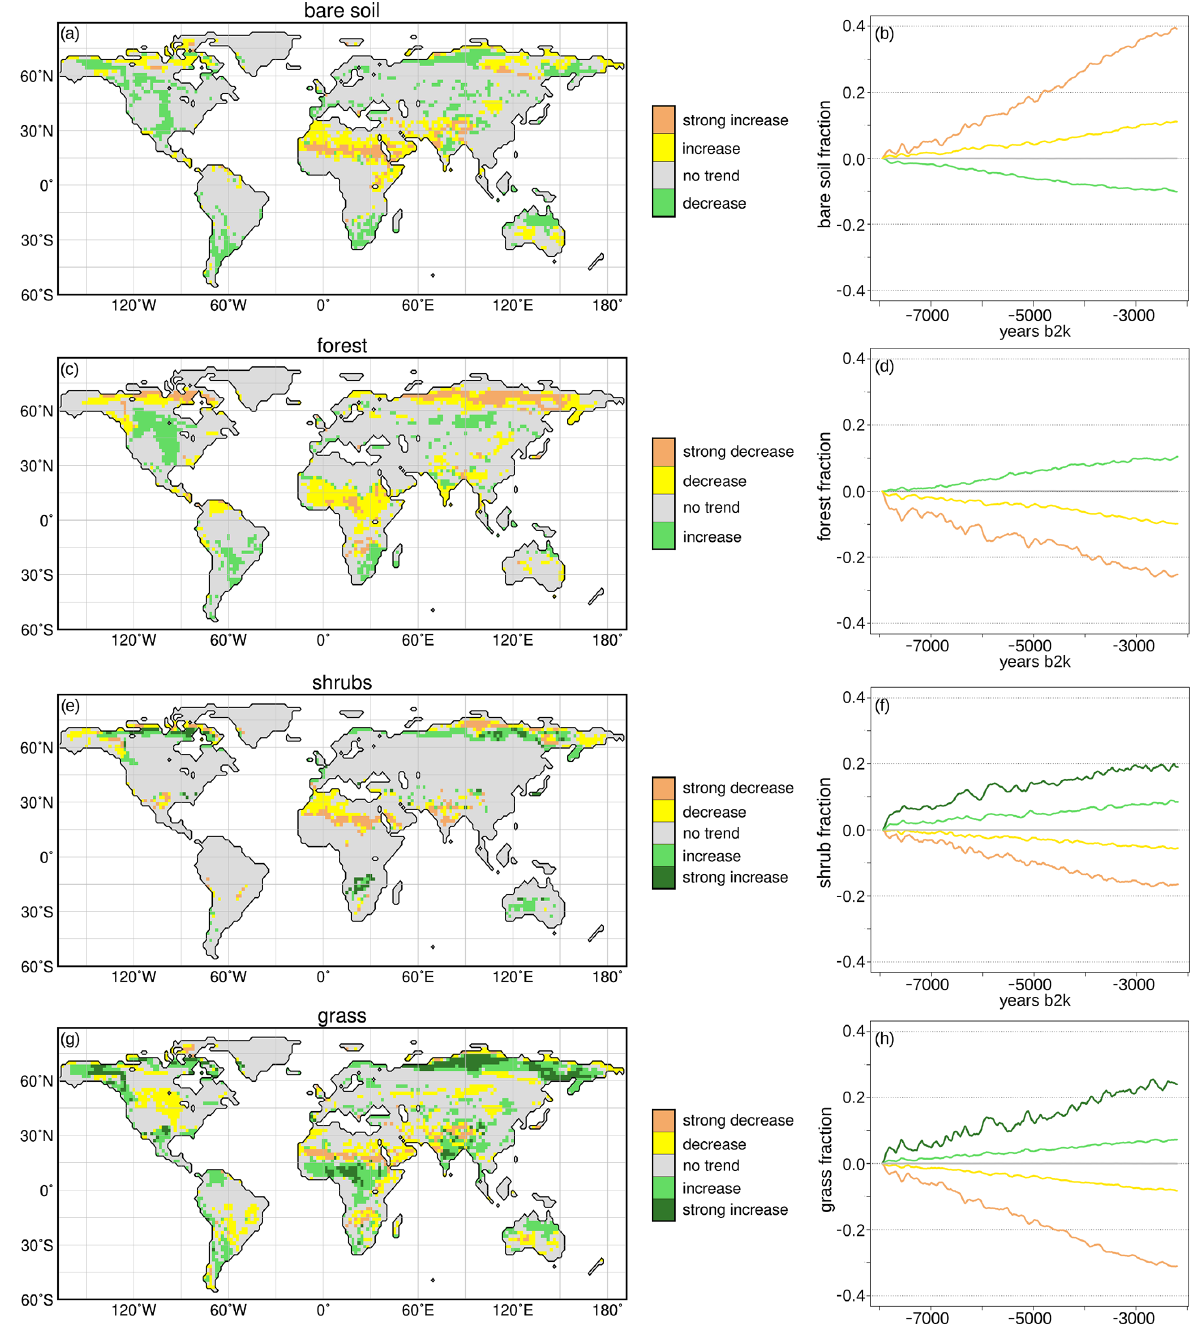
Figure 2. Simulated Holocene vegetation cluster, derived by the c -means clustering method (R, Meyer et al., 2017). The left panel displays the cluster pattern for (a) the bare soil cover, which is 1 minus the total vegetation in the model, (c) forest cover, (e) shrub cover and (g) grass cover. The right panel shows the respective trends in the cluster centres, i.e. for (b) bare soil fraction, (d) forest fraction, (f) shrub fraction and (h) grass fraction. For the analysis, 100-year running means of the anomaly time series (fraction at certain time step – 8ka climatological mean) have been taken. The cover fraction change of the cluster centres can range from − 1 to 1 in the model, i.e. decrease of 100% or increase of 100%,